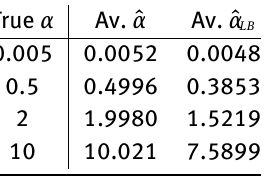
under hypotheses H LB